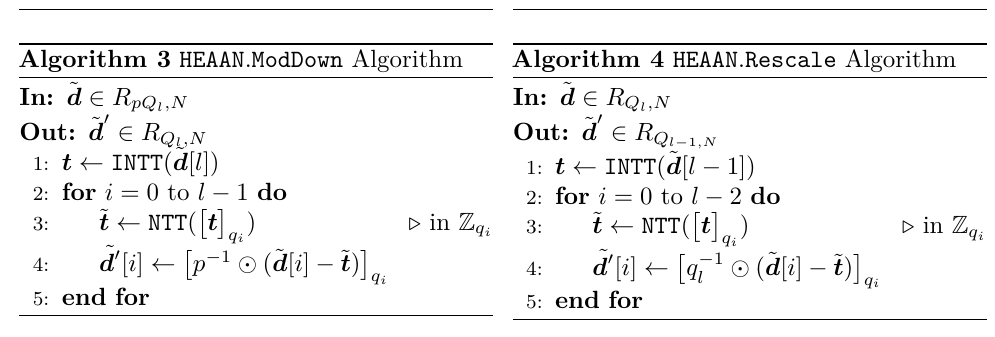
Algorithm 3 HEAAN . ModDown Algorithm Algorithm 4 HEAAN . Rescale Algorithm